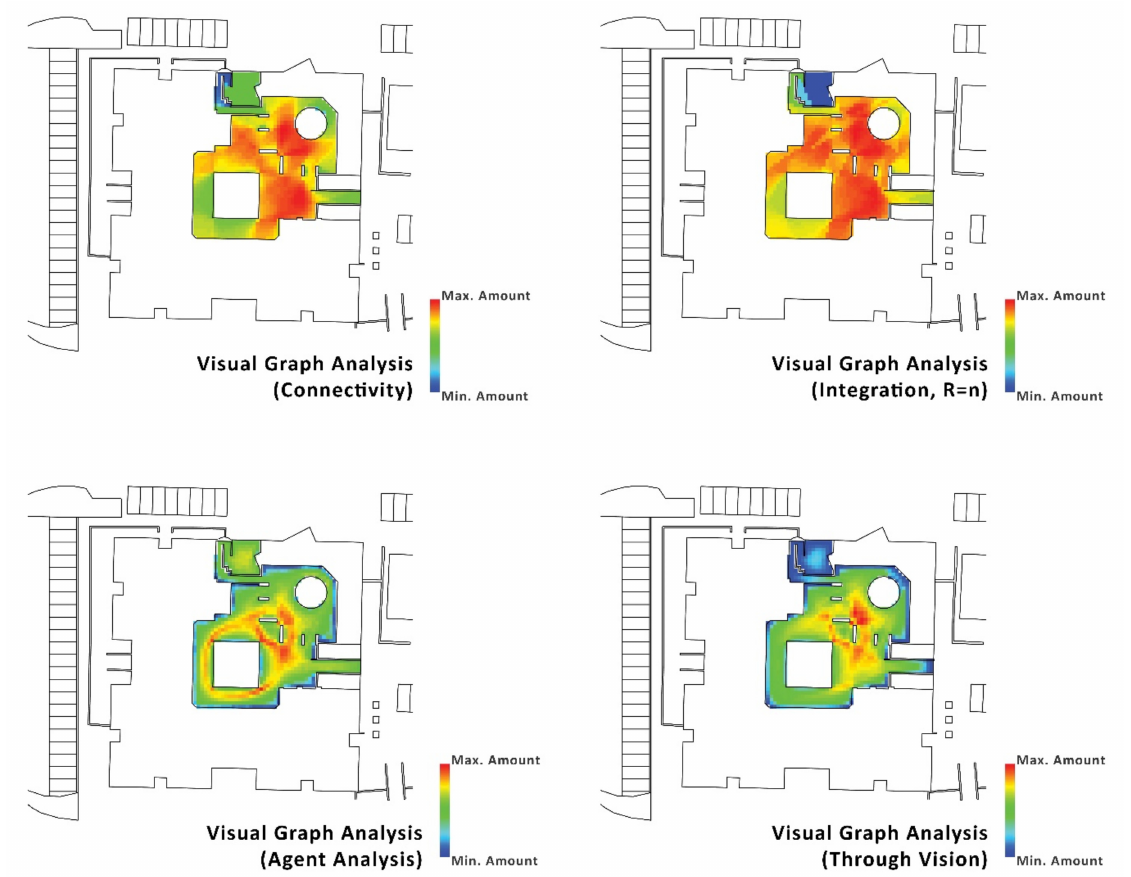
Figure 7. Visibility graph analysis (VGA) for open space